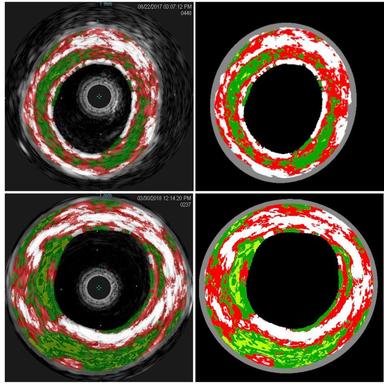
Representative IVUS-VH images extracted from the machine (left) and the segmented images for input into the finite element input file synthesis python scripts (right) for a 63 year old female patient (top, case 3) and a 87 year old male (bottom, case 8). Grey is arterial wall, light green is fatty plaque, dark green is fibrous plaque, red is necrotic core, and white is calcification.